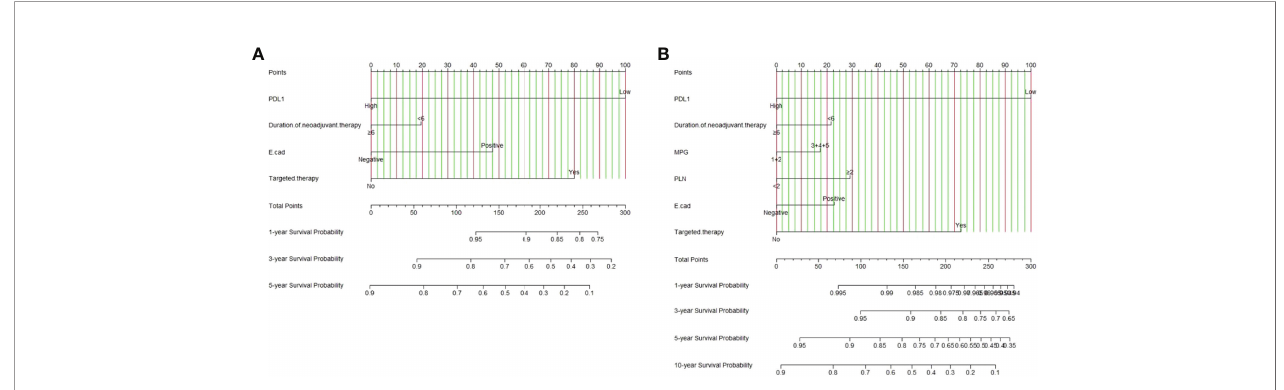
FIGURE 2 | PD-L1-based nomogram for predicting disease free survival (DFS) and overall survival (OS). A straight upward line is drawn to determine the points for every predictor. The sum of these points is situated on the total points axis, and a straight downward line shows the 1-year, 3-year, 5-year DFS estimated rates and 1-year, 3-year, 5-year, 10-year OS estimated rates. (A) PD-L1 based nomogram for predicting disease free survival (DFS); (B) PD-L1 based nomogram for predicting and overall survival (OS). E-cad, E-Cadherin; PLN, positive axillary lymph